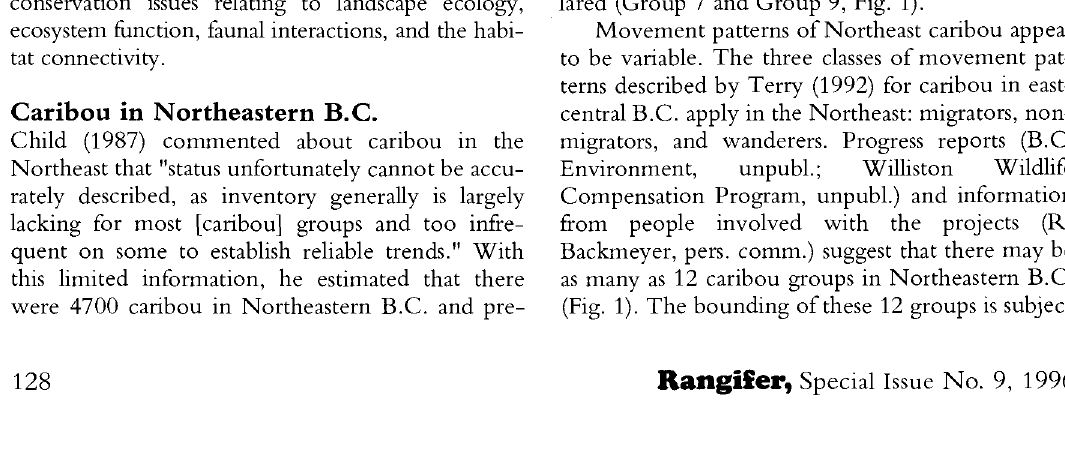
Fig. 1. Caribou Groups in Northeastern British Columbia. Group bondaries are estimated from radio-collar data and from field reports of caribou movment.